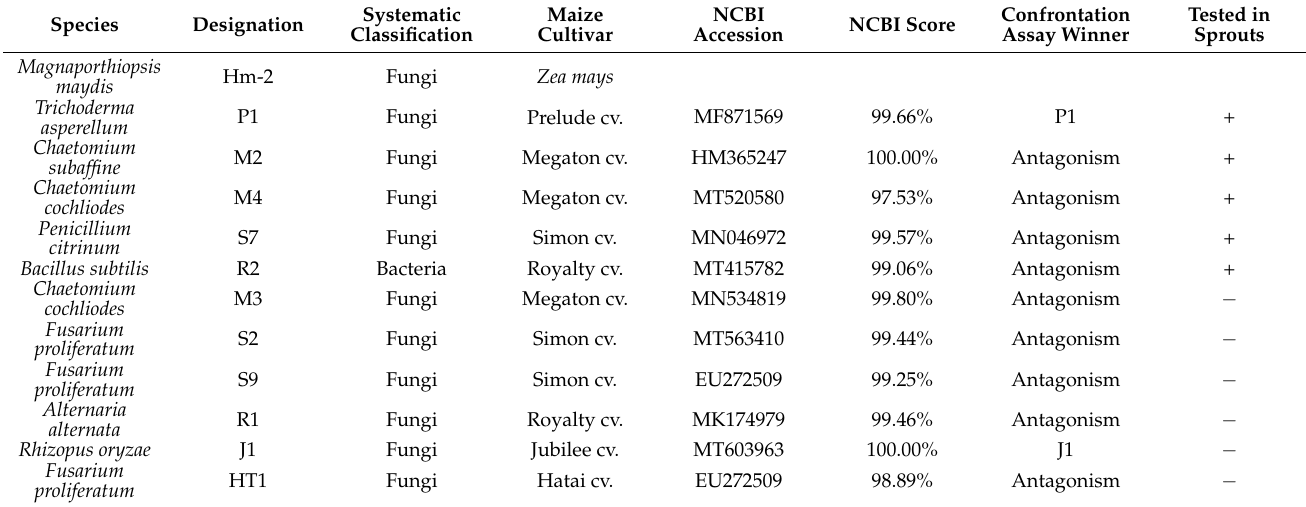
Figure 1. Isolation of endophytes from maize grains. Maize seeds were externally disinfected, cut lengthwise, and placed on a potato dextrose agar (PDA) substrate with the cutting surface turned downwards. Petri plates were incubated at 28 ± 1 ◦ C in the dark for 2–3 days. At the end of this period, the fungal and bacterial endophytes that developed were isolated into new PDA plates and subjected to molecular identification. Table 3. Endophytes identified in this study and plate confrontation assay results 1